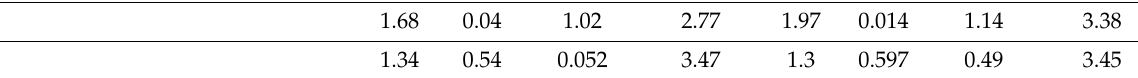
Socio-Demographic